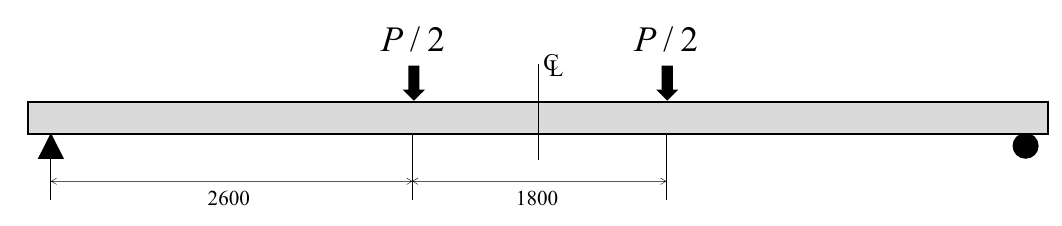
Figure A4. Loading Figure A4. Loading details. Figure A4. Loading details.